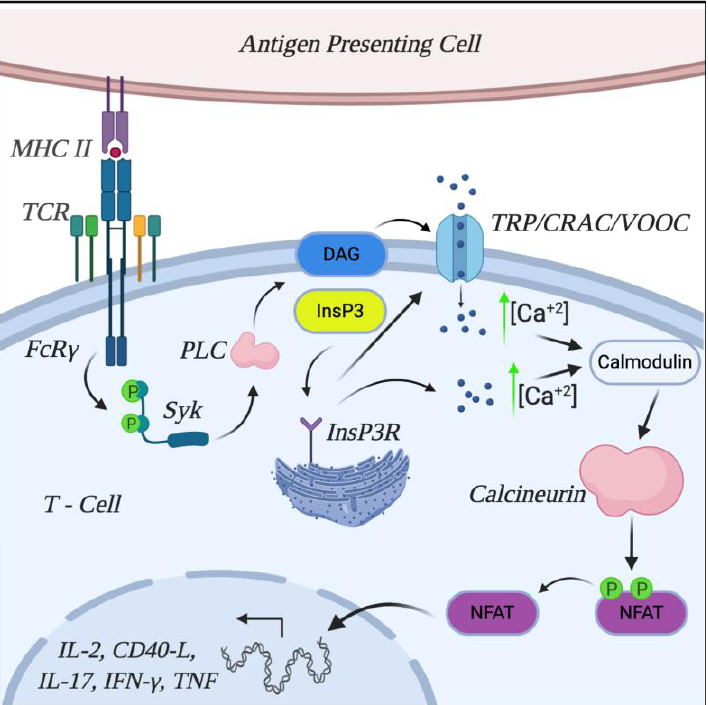
Figure 1. T cell receptors (TCR) signaling and the role of calcineurin in systemic lupus erythematosus. After antigen presentation to T0 cells in SLE patients, TCR rewiring occurs, so the ζ chain is replaced by Fc receptor gamma (FcRγ), which binds to the spleen tyrosine kinase (Syk) and induces the phosphorylation of the phospholipase C (PLC). This phosphorylation induces the release of inositol-1,4,5-trisphosphate (InsP3) and diacylglycerol (DAG). The release of DAG in the membrane promotes the activation of membrane channels calcium release-activated channels (CRAC), Transient Receptor Potential (TRP) channels and voltage-gated Ca +2 channels (VOCC), allowing the entry of calcium from the extracellular space. Then, InsP3 migrates to the endoplasmic reticulum, where it binds to the InsP3R receptor and induces an influx of calcium into the intracellular space. The intracellular calcium binds to calmodulin and leads to activation of calcineurin phosphatase. Calcineurin dephosphorylates the nuclear factor of activated T-cell (NFAT) and induces the translocation of this transcription factor to the nucleus, where it promotes the expression of several key genes such as Interleukin (IL)-2, IL-17, tumor necrosis factor (TNF), interferon (IFN)-γ and CD40-L(igand).